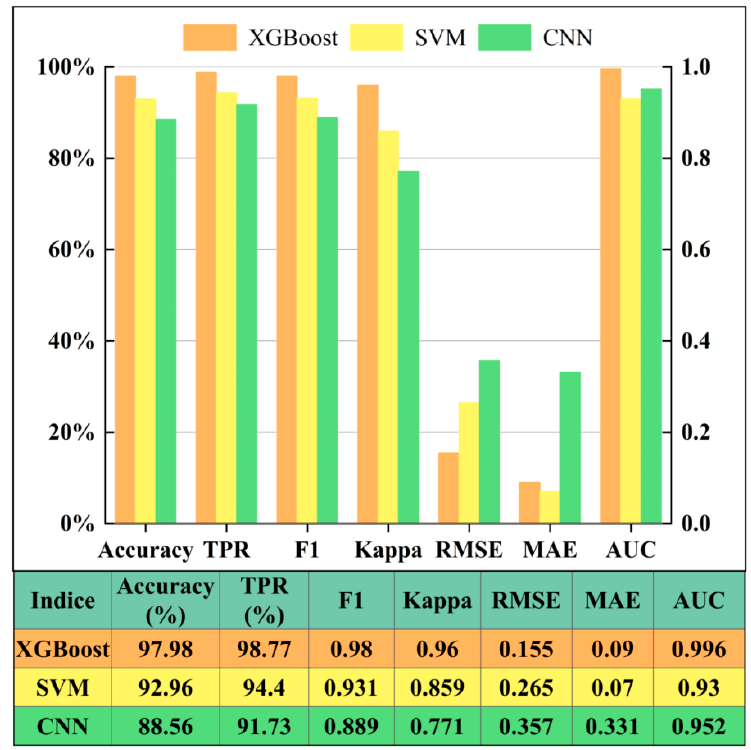
Figure 11. Precision comparison of landslide susceptibility assessment by the three algorithms.